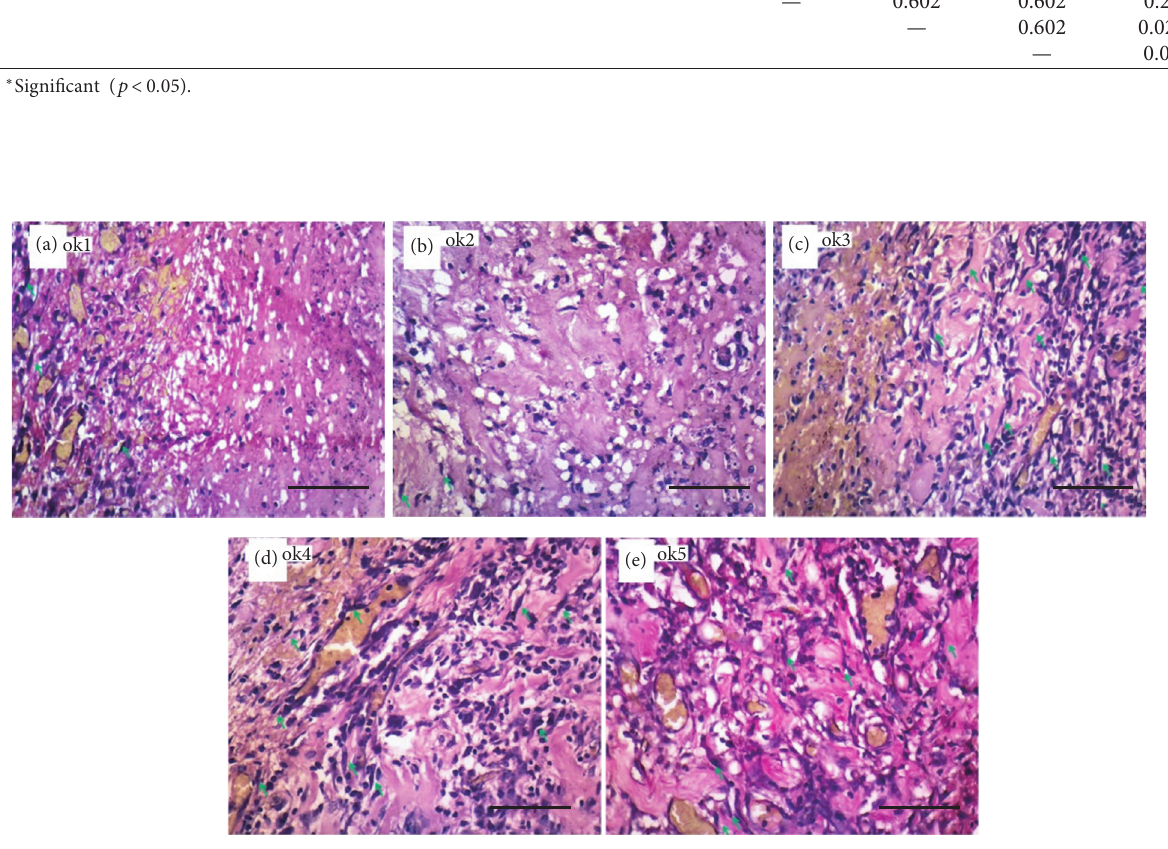
Figure 1: The number of fibroblasts on day 3. (a) Control group with nonozonated Aloe vera oil. (b) Control group with gentamicin application. (c) Treatment group with 600mg ozonated Aloe vera oil. (d) Treatment group with 1,200mg ozonated Aloe vera oil. (e) Treatment group with 1,800mg ozonated Aloe vera oil. Scale bar 50 μ